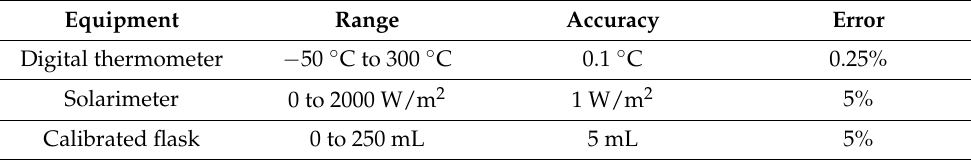
Table 2. Technical specifications of measurement